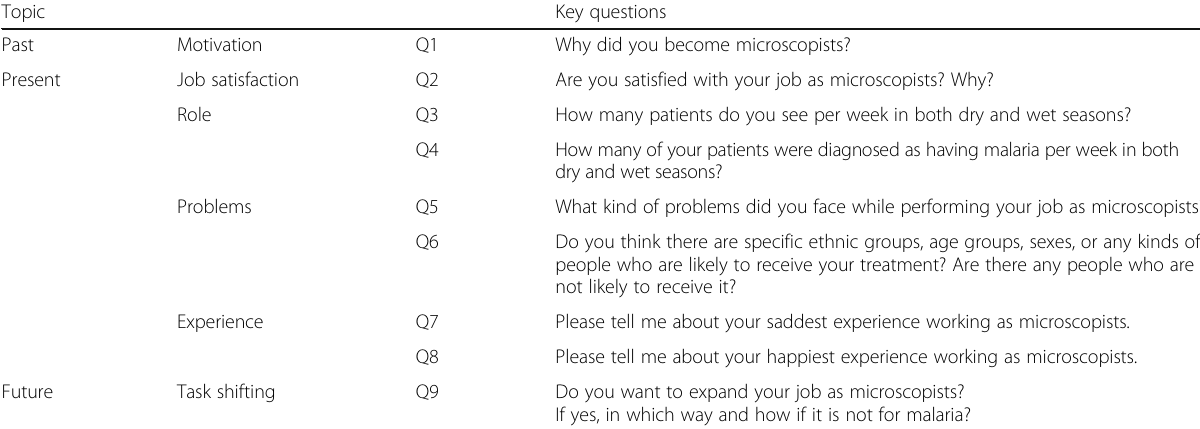
Table 3 Focus group topics and key questions Topic